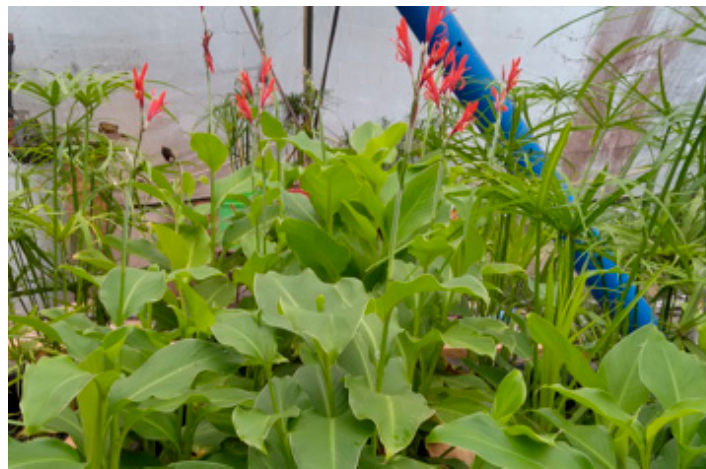
3 Table 1. Some characteristics of Canna indica. Characteristics Description of Characteristics Plant description